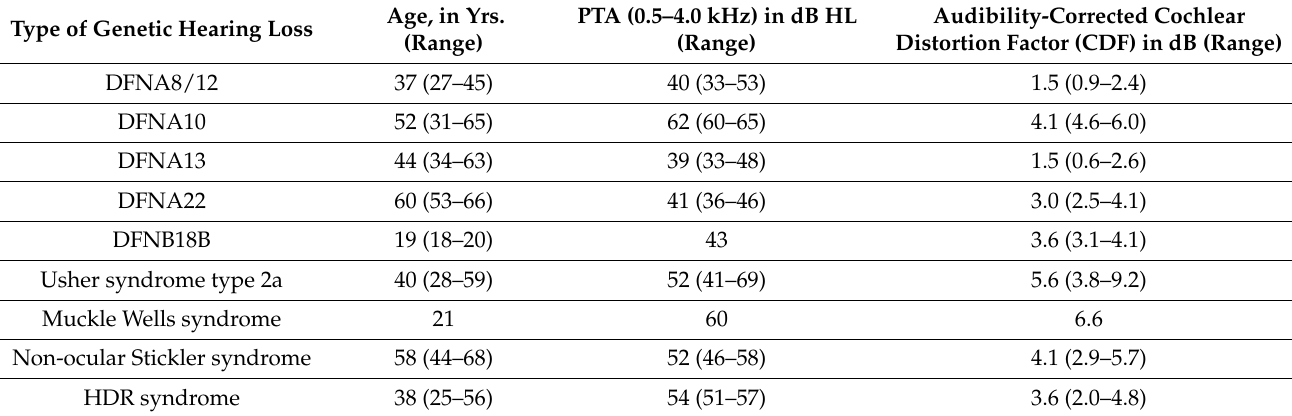
Table 2. Characteristics of the patient